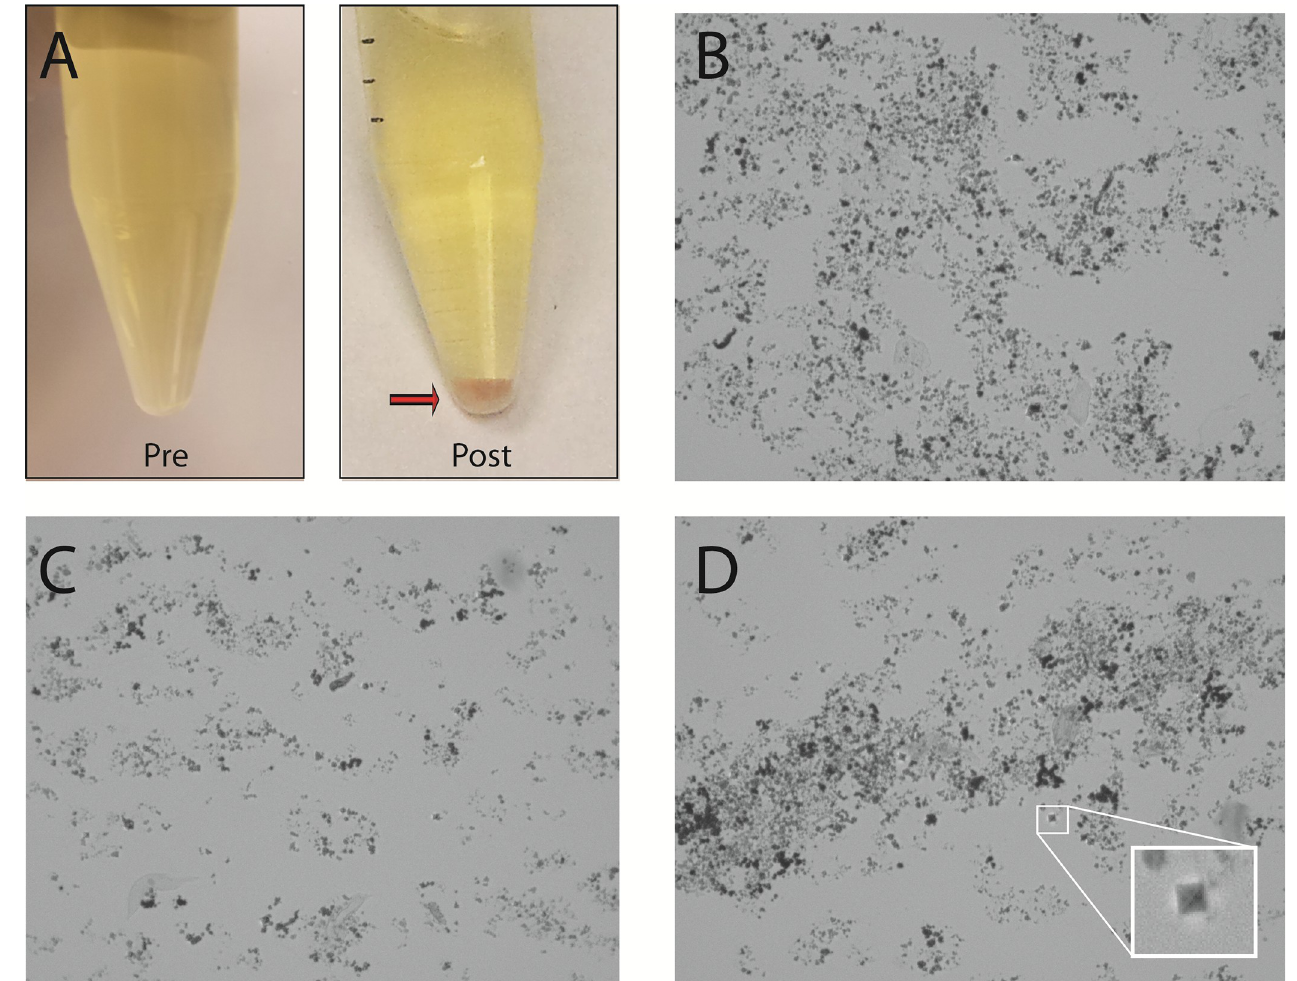
Fig 4. Urine storage and centrifugation conditions impact DNA extraction efficiency. In a subset of urine samples, both refrigeration and high-speed centrifugation were associated with precipitation of varying crystals that interfered with DNA purification. (A) A single urine specimen before and after refrigeration and centrifugation at 5000 rcf. In the post-centrifugation specimen, a red-orange, sandy pellet was observed after centrifugation consistent with the “brick-layer’s dust” characteristic of amorphous urates. (B) The pellet seen in A was examined by light microscopy (x400 magnification), revealing disorganized amorphous urate crystals. (C) Amorphous phosphates from alkaline urine. (D) The “envelope”-type crystals characteristic of calcium oxalate could also be identified in urine (magnified in the inset picture), but did not constitute the majority of the crystalline material.